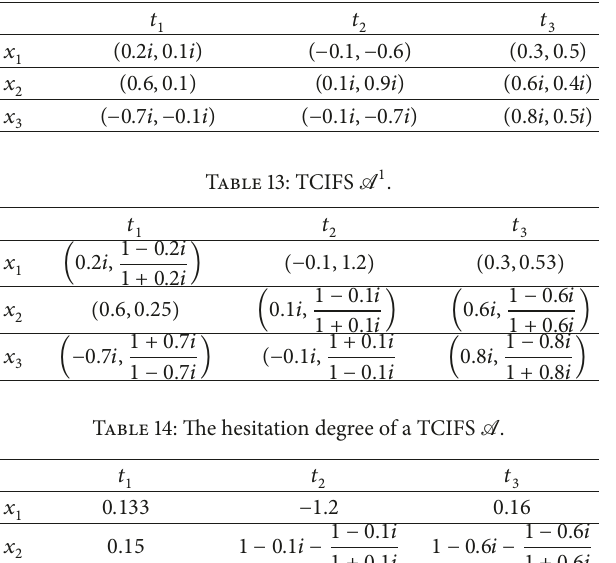
Table 12: TCIFS A .